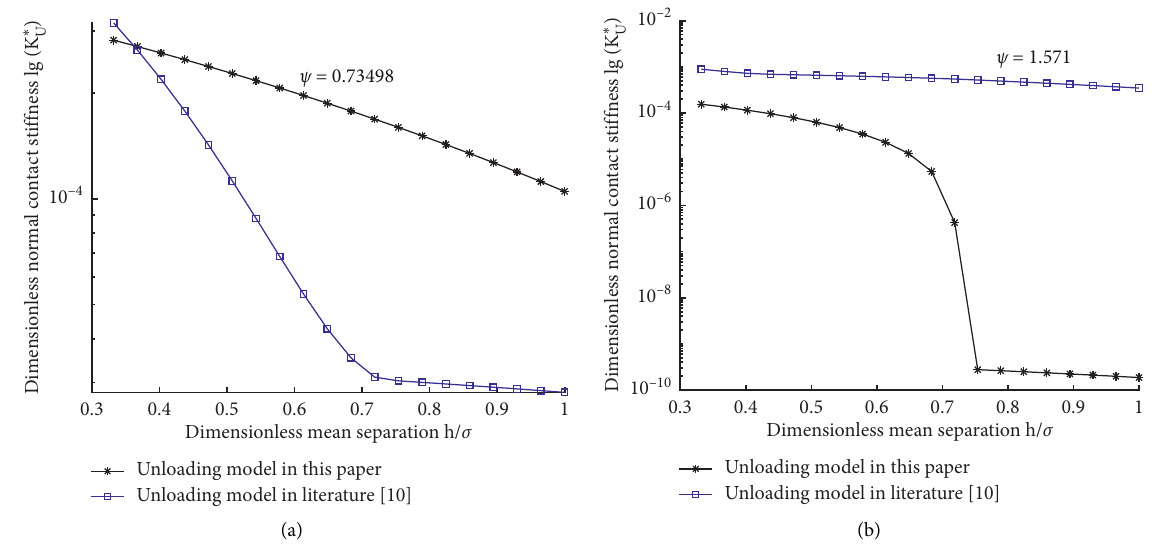
Figure 5: A comparison between the unloading model in this paper and that in [10]. (a) ψ � 0 . 73498. (b) ψ � 1 .